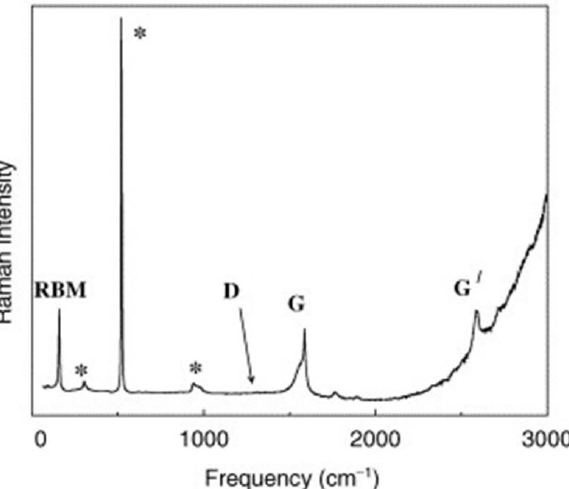
Figure 3. Raman spectra of isolated SWCNTs collected using a laser source with a wavelength of 785 nm [77]. Bands marked with * are due to the substrate of Si/SiO 2 . Reprinted with permission from Elsevier. Copyright 2002